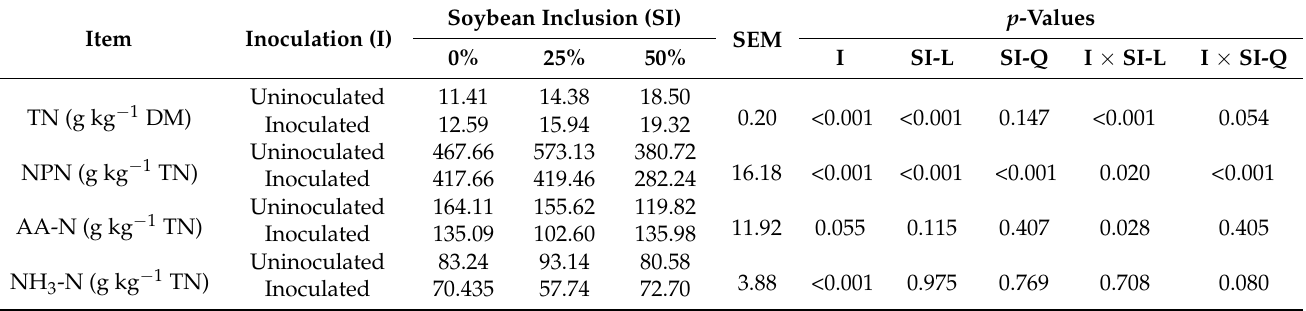
Table 3. Influence of soybean inclusion and L. plantarum A1 inoculation on N fractions of sorghum